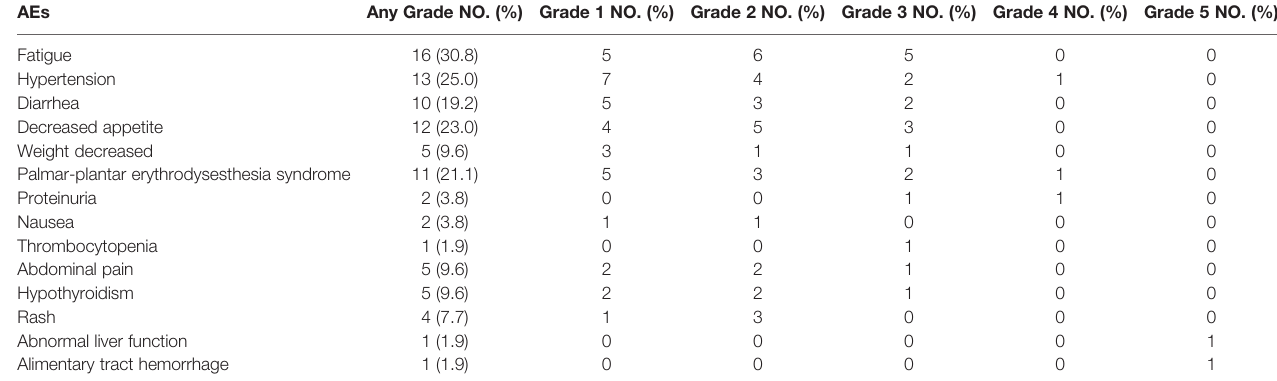
TABLE 2 | Treatment-related adverse effects.